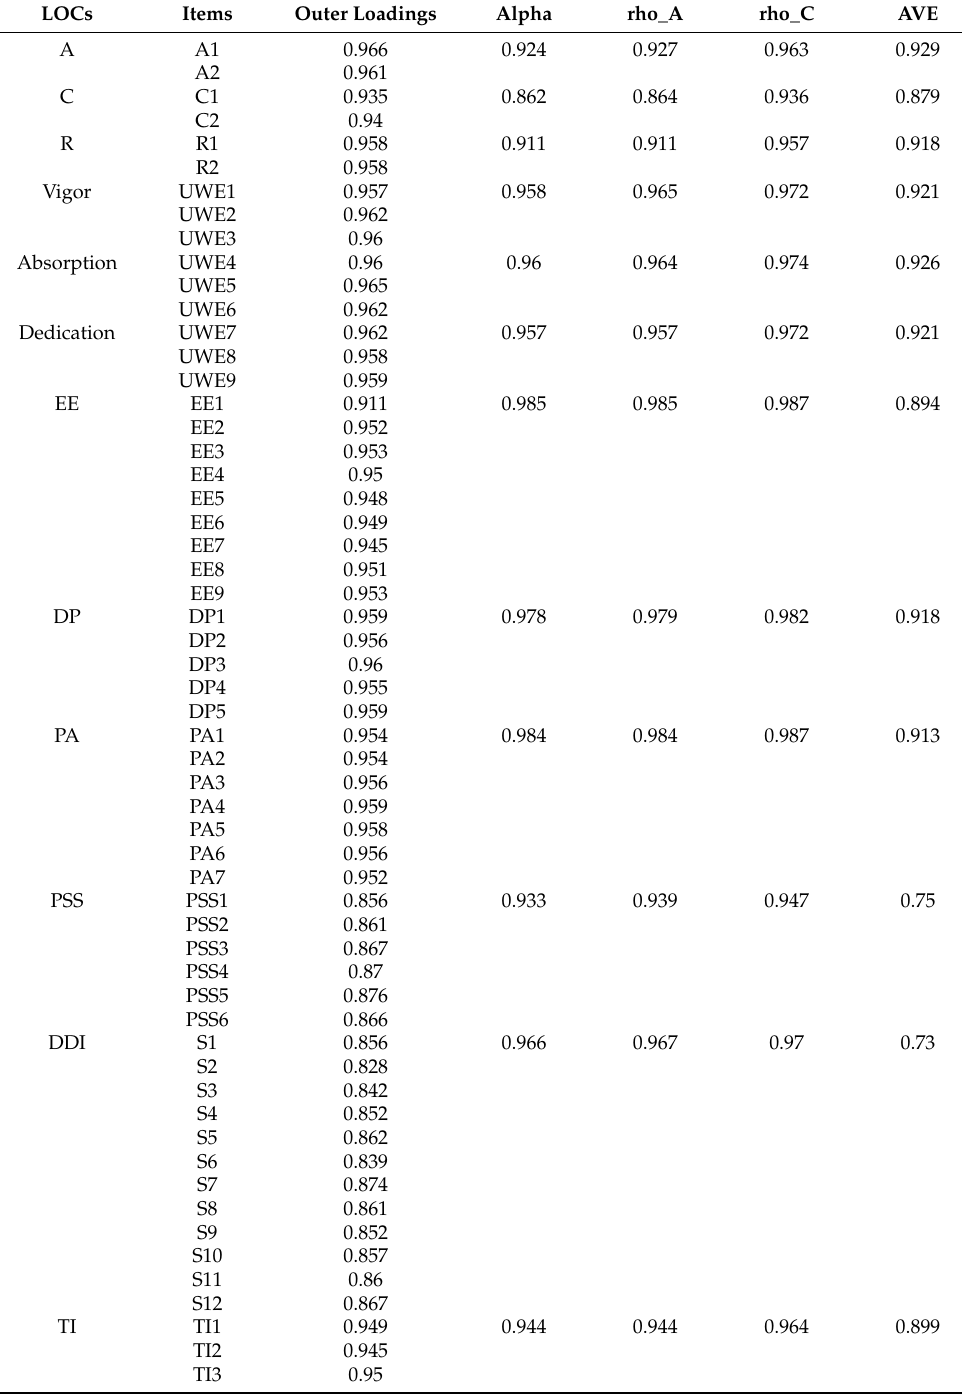
Table A4. Stage 1—Outer loadings, Reliability, Convergent